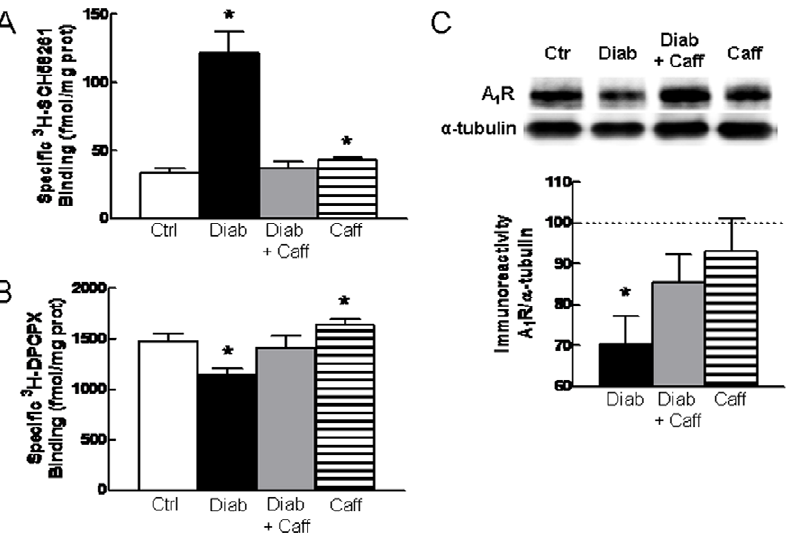
Figure 6 . Diabetes increases A 2A R density and decreases A 1 R density in hippocampal nerve terminals . A 2A R (A) and A 1 R density (B) were measured as the specific binding of a supra-maximal concentration (6 nM) of the selective antagonists of A 2A R ( 3 H-SCH58261) and A 1 R ( 3 H-DPCPX) in membranes from hippocampal nerve terminals of control (open bar), diabetic (black bars), diabetic treated with caffeine (grey bar) and control treated with caffeine (striped bars) (n=5–6). Panel (C) displays a Western blot comparing A 1 R immunoreactivity in control or diabetic (Diab) mice without or with caffeine (Caff) treatment, as well as the average results of A 1 R immunoreactivity (% of control) in 6 such experiments. *P , 0.05 versus control.